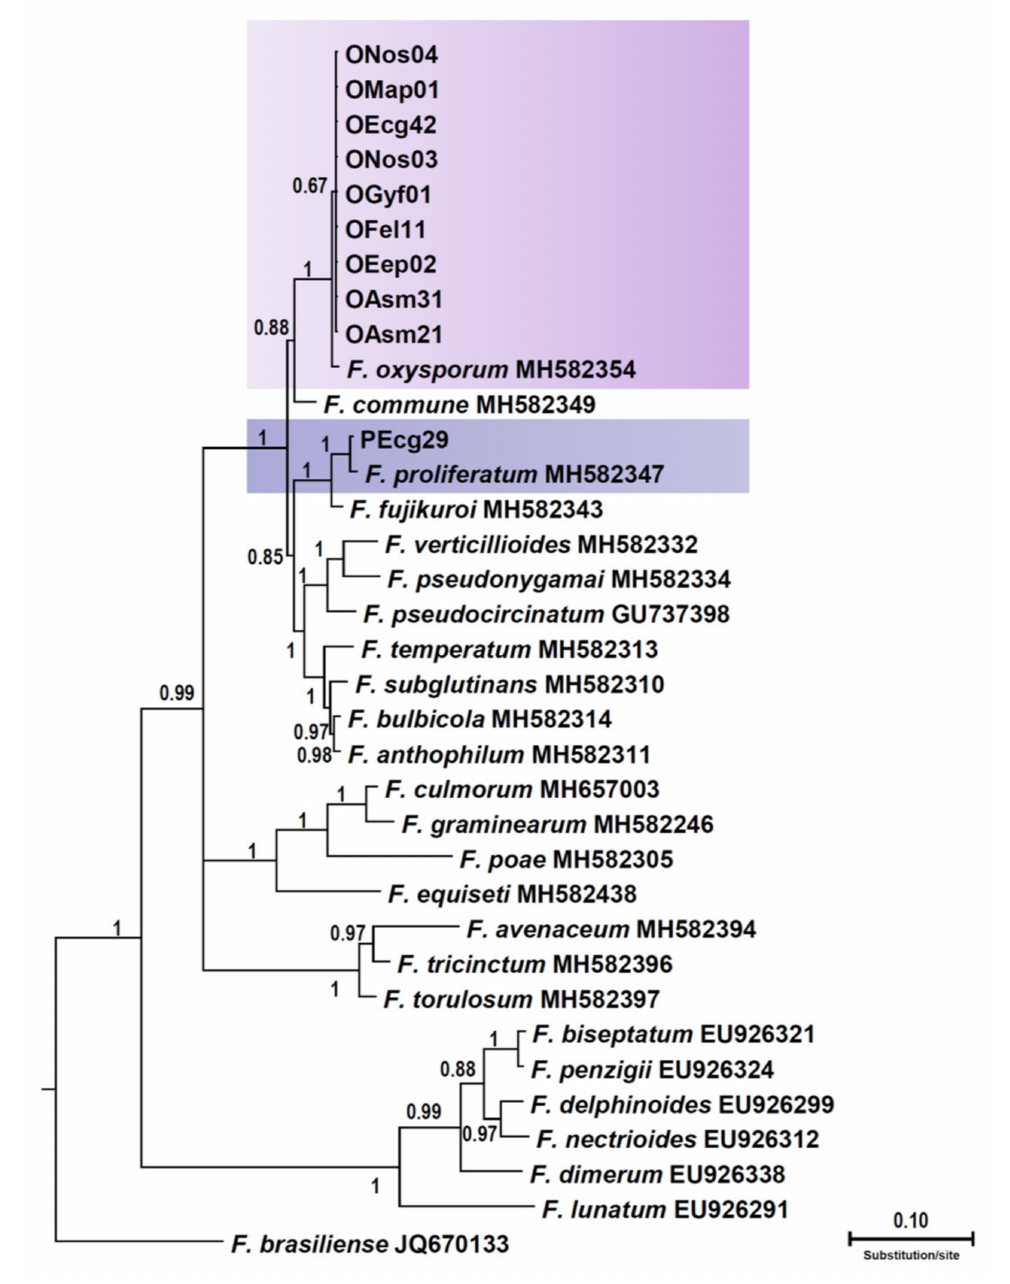
Figure 3. Phylogenetic relationships of Fusarium species recovered from Shiraz County greenhouses with 24 Fusarium species based on Bayesian analysis of translation elongation factor1- α ( tef1 ) se- quences. Numbers above the branches represent the posterior probability based on Bayesian analysis. Isolates retrieved from succulent plants in Iran are shown in bold (or arrows point at isolates retrieved form succulent plants in